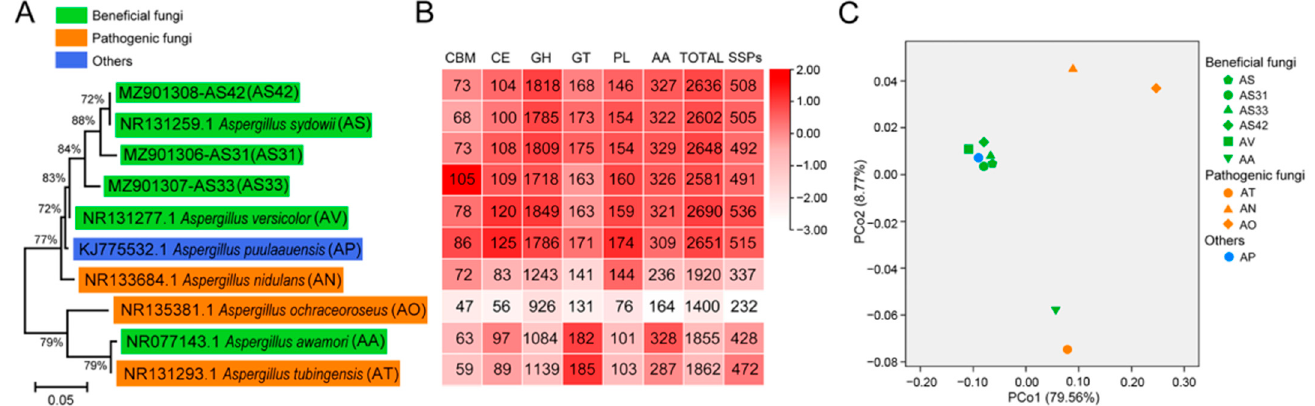
Figure 5. Comparative analysis of CAZyme and secretome encoded in the genomes of AS31, AS33, AS42, and related species. ( A ), Maximum likelihood (ML) phylogenetic tree showing the evolutionary relationships of six beneficial (green) species, three pathogenic (orange) species, and one other (blue) species. The names in brackets refer to the abbreviation of each species. ( B ), Numbers of CAZymes and SSPs encoded in the 10 genomes according to A. CBM, carbohydrate-binding module; CE, carbohydrate esterase; GH, glycoside hydrolase; GT, glycosyl transferase; PL, polysaccharide lyases; AA, auxiliary activity; TOTAL, total number of CAZymes; SSPs, small secreted proteins. ( C ), Principal coordinates analysis (PCoA) of CAZyme and secretome based on gene numbers. The abbreviation of each species is the same as A.